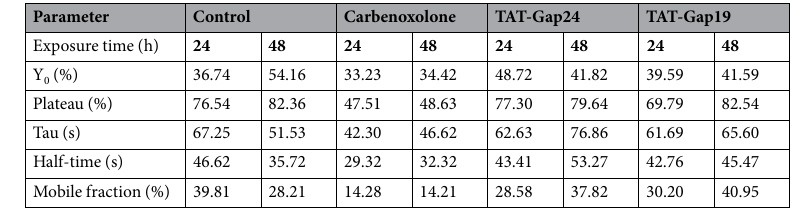
Table 1. Calculations of FRAP curve parameters following a non-linear curve fit of control, carbenoxolone, TAT-Gap24 and TAT-Gap19 after 24 h and 48 h of